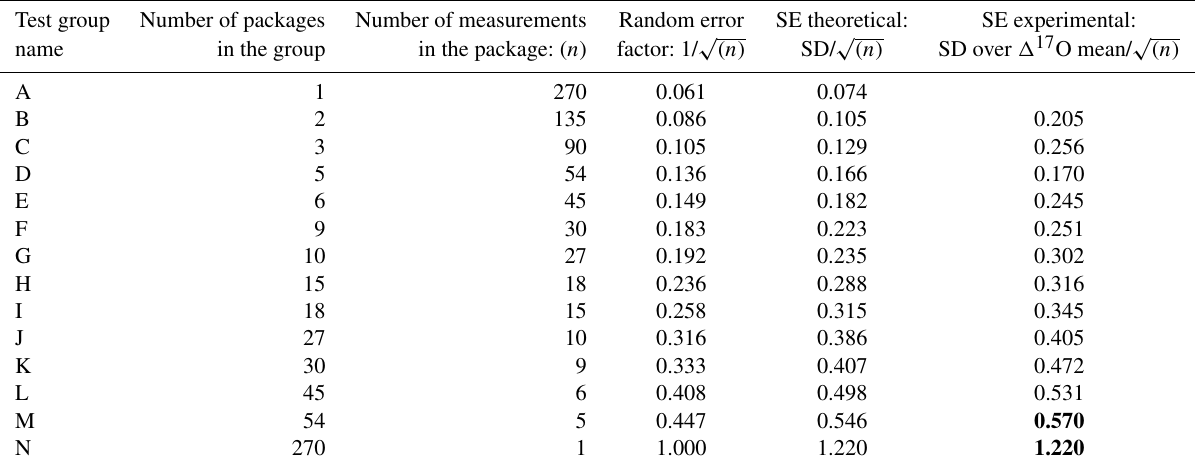
Table 1. Statistical improvement of (cid:49) 17 O analytical error by combining multiple ( n ) measurements of the same gas into packages and taking the standard error of these